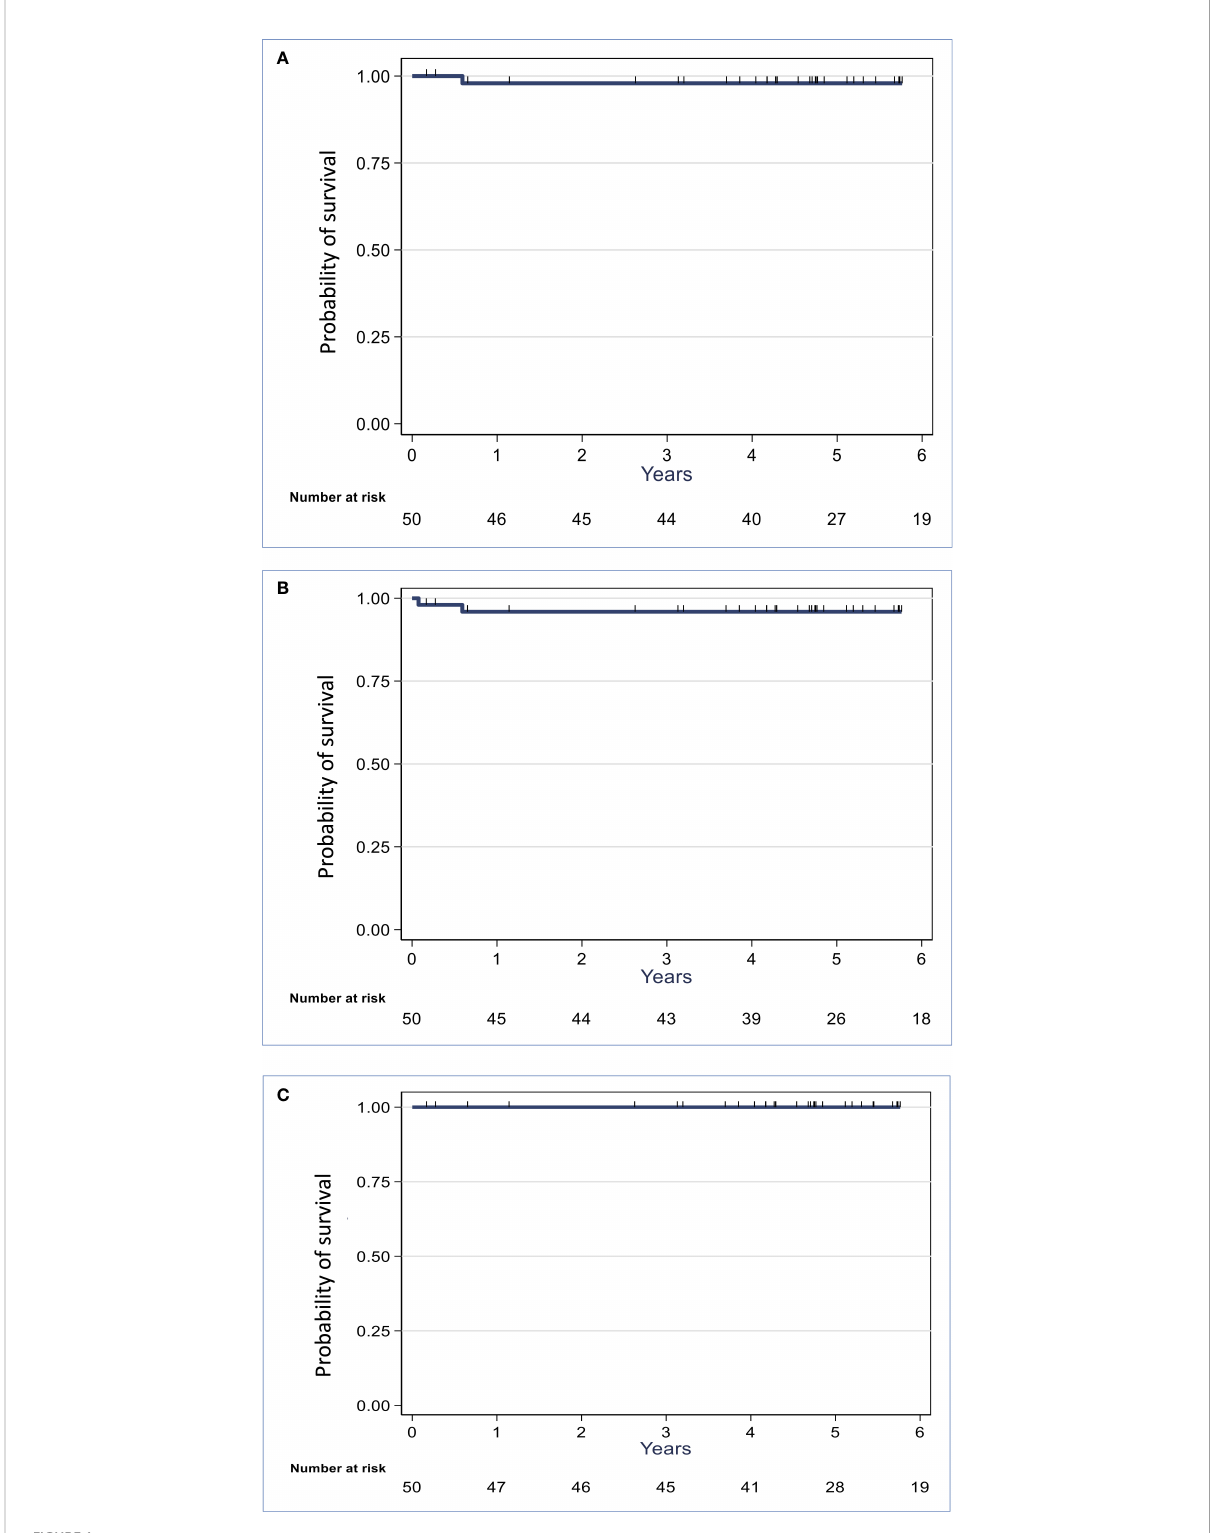
FIGURE 1 Kaplan-Meier locoregional-free (A) , recurrence-free (B) and overall (C) survival curves for the patients with initially non-metastatic synchronous bilateral breast cancer